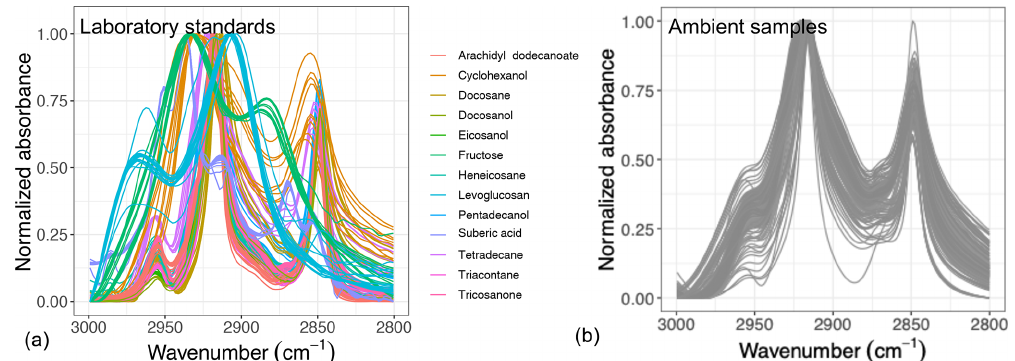
Figure 1. Normalized aliphatic C − H spectra of the laboratory standards (a) and several atmospheric samples (b) . This figure shows variation in absorbance profile among the standards and atmospheric